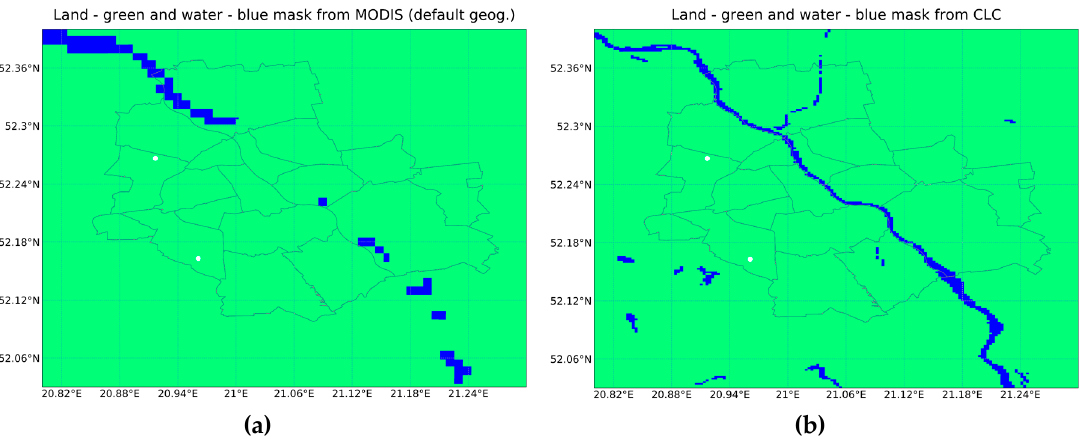
Figure 3. The water mask used in the WRF model for Warsaw from ( a ) MODIS data (default); ( b ) CLC data.